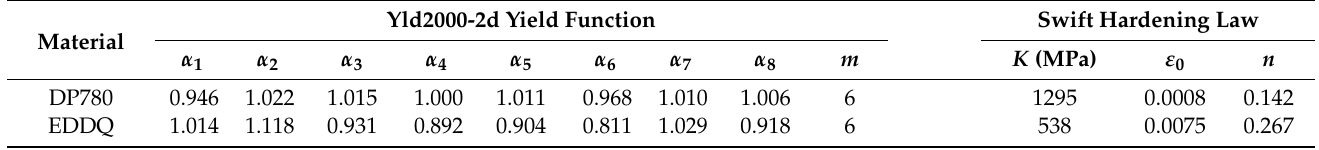
Figure 14. Schematic illustration of the specimens used in the two-step uniaxial tension tests: ( a ) the sub-specimen at the center of the big-specimen and ( b ) directions of the second tension [6]. Table 2. Coefficients of yield function and hardening law for DP780 and EDDQ (Data from [6]). Yld2000-2d yield function Swift hardening law Material